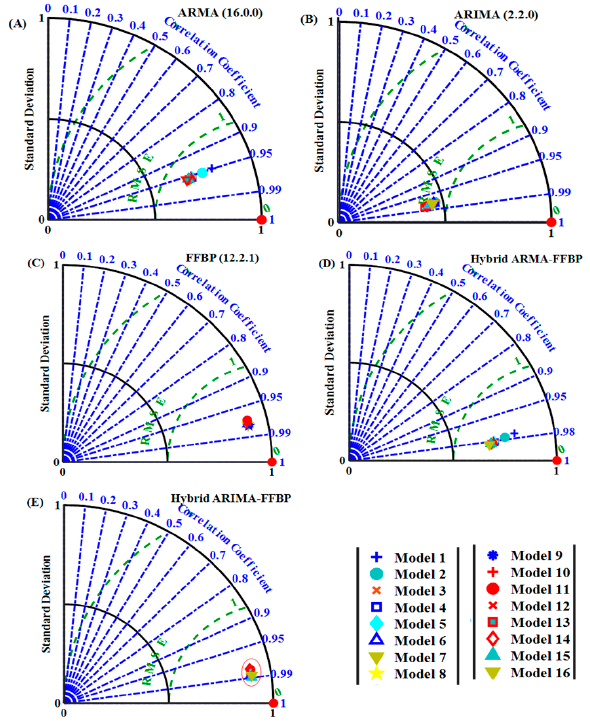
Figure 12. Taylor diagram of several ( A ) ARMA, ( B ) ARIMA, ( C ) FFBP, and ( D , E ) hybrid models of Tangier city. Tangier